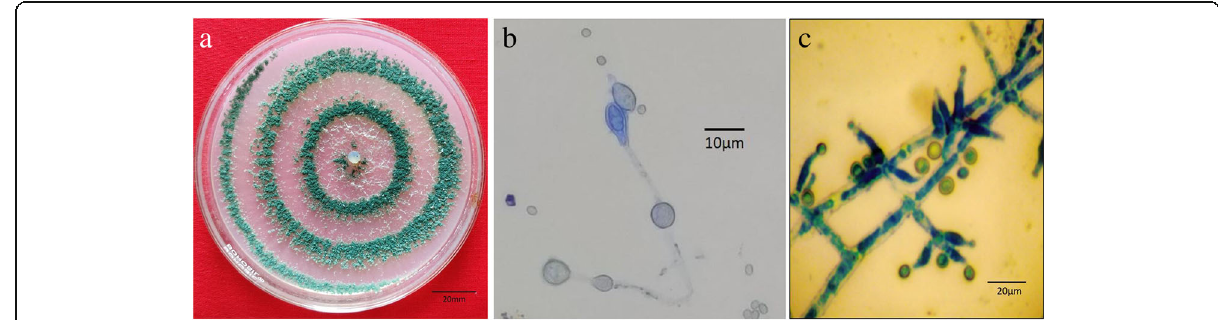
Table 1 Colony morphology and biochemical characters of the isolated Trichoderma strains Isolate Growth of the colony after 72 h at 26 ± 2 code °C (radius in mm)